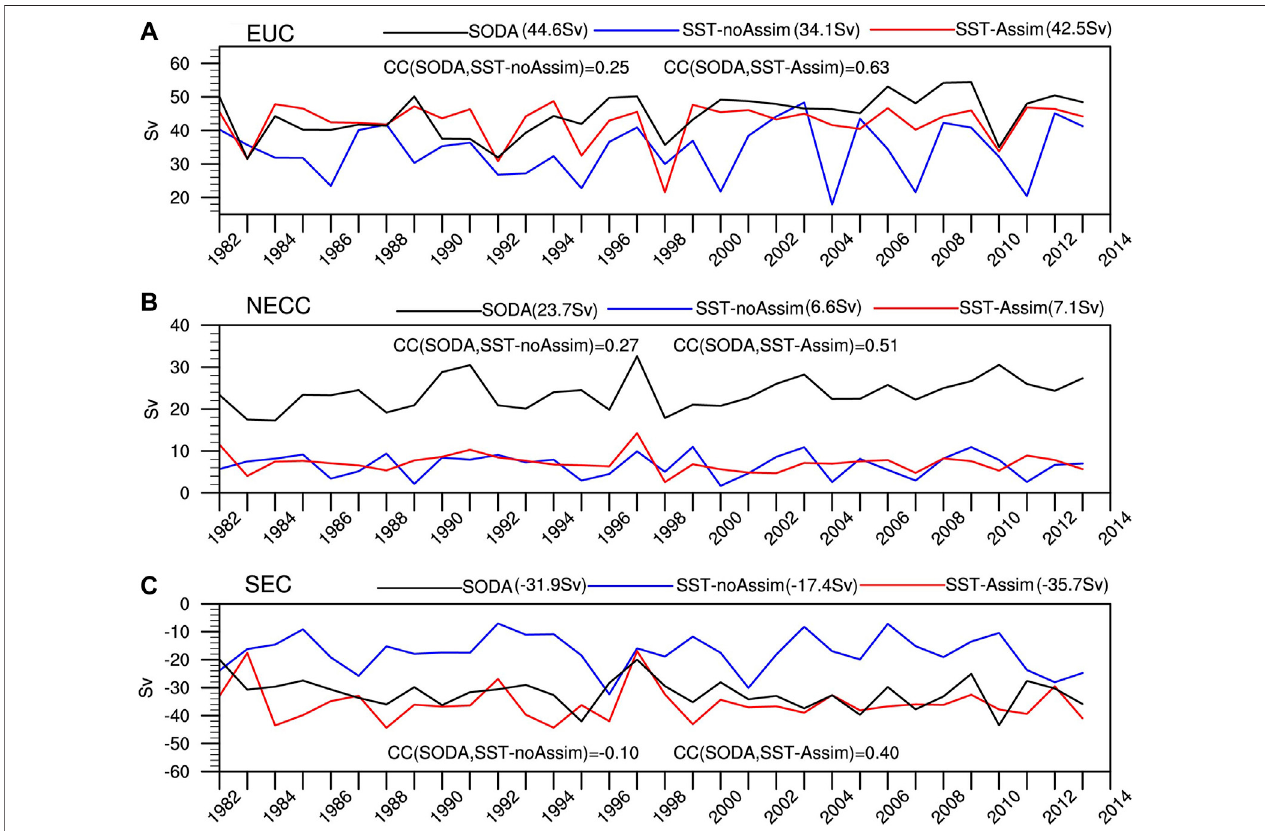
FIGURE4| Theinterannualvariabilityofthezonalvolumetransportat140 ° WofthePaci fi c (A) EUC, (B) NECCand (C) SECoftheSODA(black line),SST-noAssim experiment (blue line) and SST-Assim experiment (red line), respectively (units: Sv; 1Sv = 106 m3/s). Values in the parentheses mean the annual average values from 1982 to 2013 at 140 ° W. The abbreviation “ CC ” represents the correlation coef fi cient value.